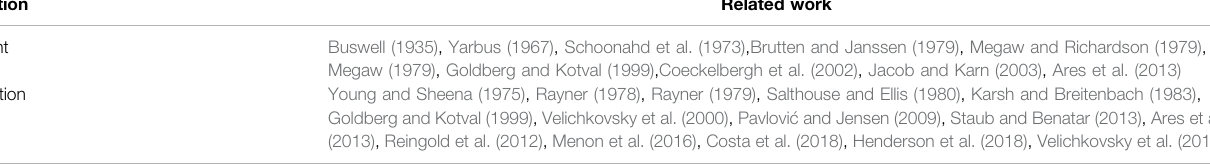
TABLE 1 | Summary of related work on eye movement and pupil